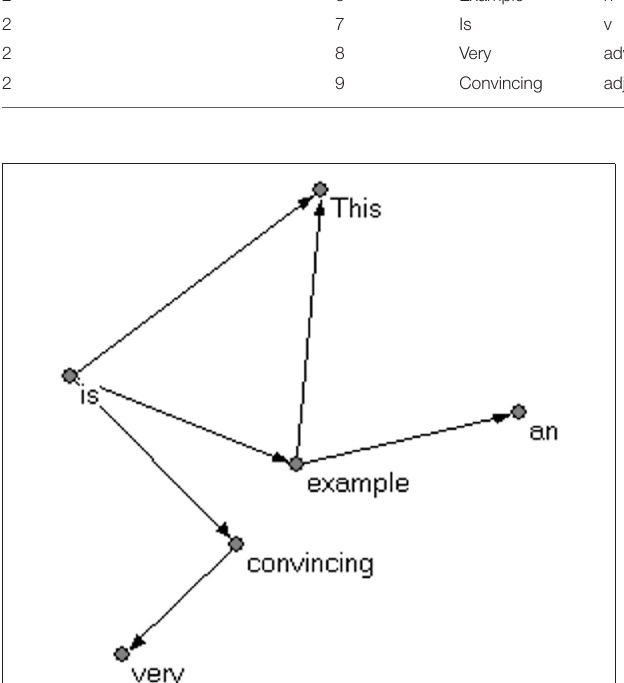
FIGURE 3 | An example of syntactic dependency